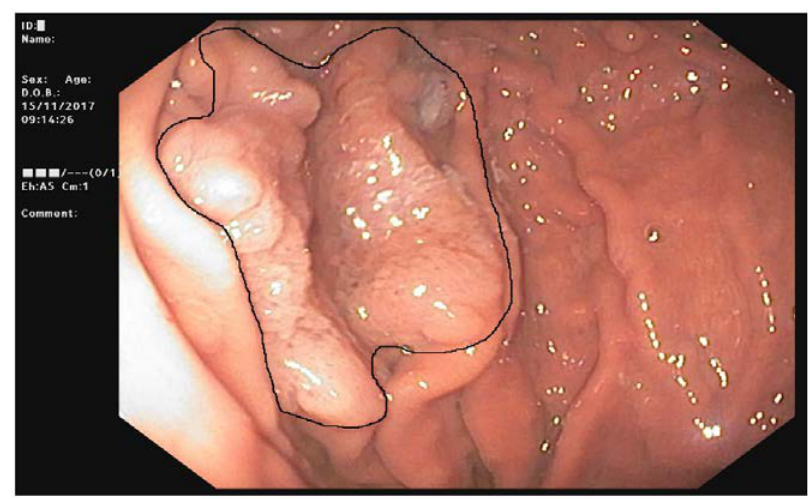
Figure 6. Flat adenoma in fundic gland polyposis.